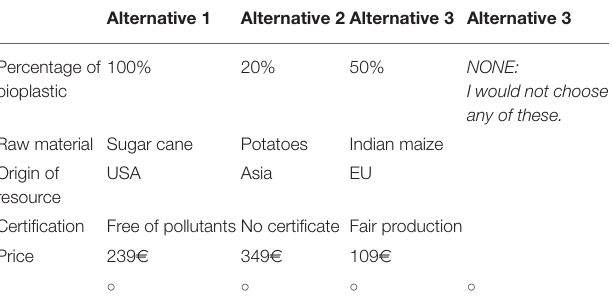
TABLE A2 | Choice set (example for random